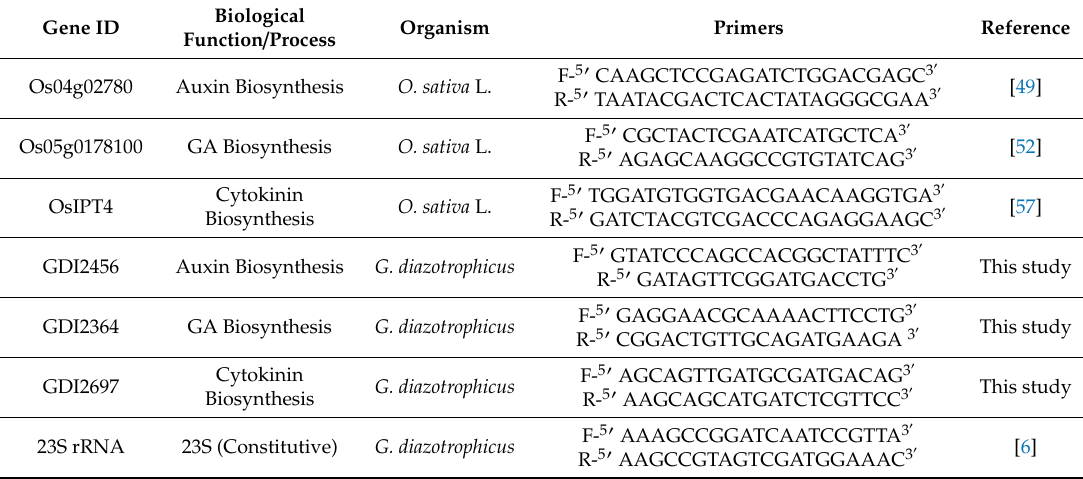
Table A2. Identified genes for phytohormone in rice and G.